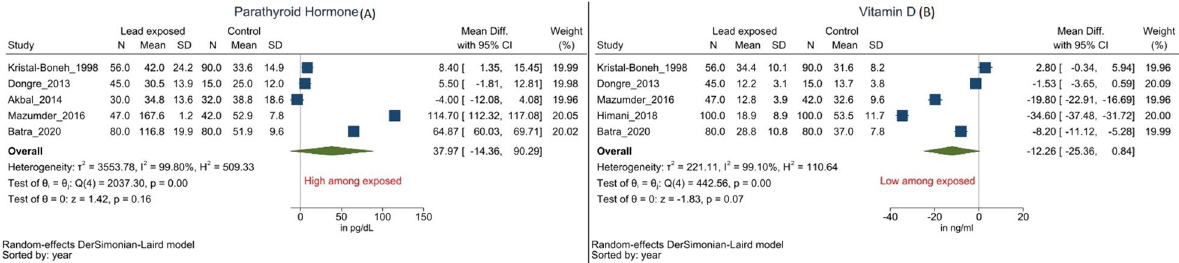
Figure 4. Forest Plot for parathormone ( A ) and Vitamin D ( B ). (Legends/footnotes) Group differences in paratharmone ( A ) and vitamin D ( B ) between the occupationally Pb exposed and unexposed control workers. Forest plot for association between occupational Pb exposure and Paratharmone ( A ) and Vitamin D ( B ) levels. (Legends/footnotes): Forest plot revealing the group mean differences in parathormone in pg/dl ( A ) and vitamin D in ng/dl ( B ) between the occupationally Pb exposed workers and control participants. The square and whisker (horizontal line) represent respectively the mean difference and 95% confidence interval of individual studies. The length and width of the diamond indicate respectively the pooled mean difference and 95% confidence interval derived from random-effect markers in urine (deoxypyridinoline and hydroxyproline) and bone resorption markers (osteocalcin) were higher among the occupationally Pb exposed as compared to the control group; however, the results of urinary bone turnover markers (deoxypyridinoline and hydroxyproline) were statistically significant ( P < 0.05).